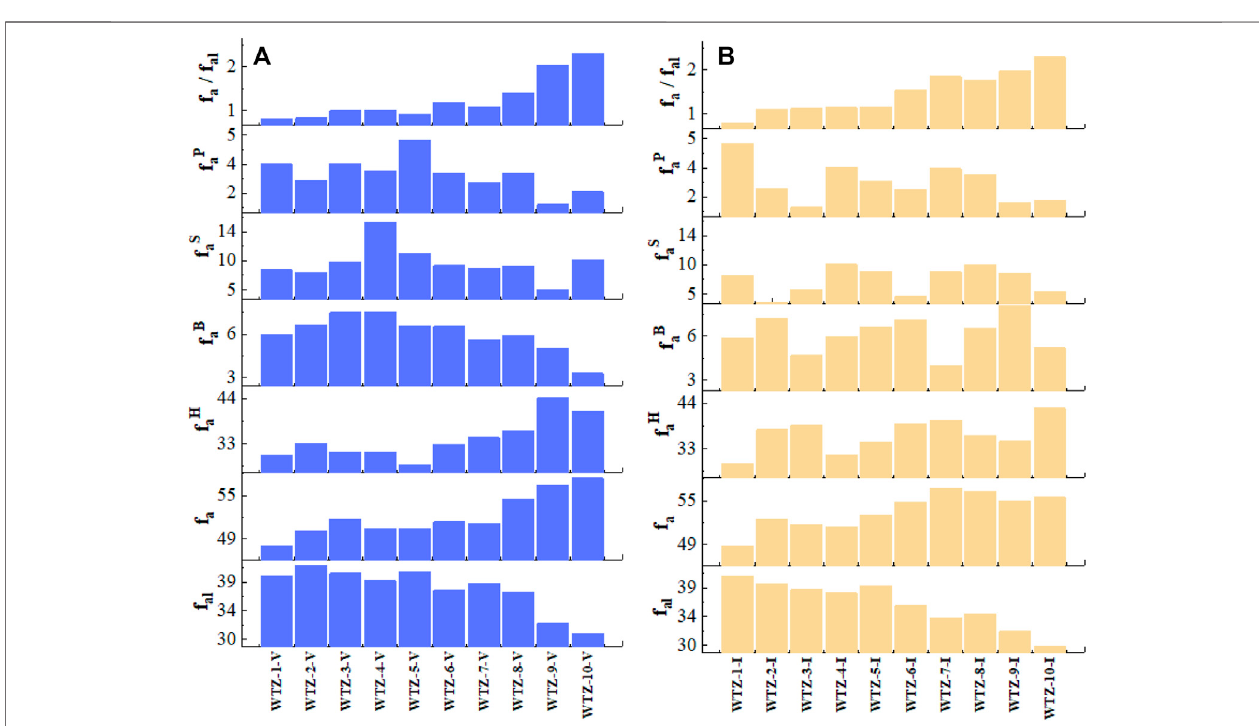
FIGURE 4 | NMR structure parameters of vitrinite (A) and inertinite (B) .